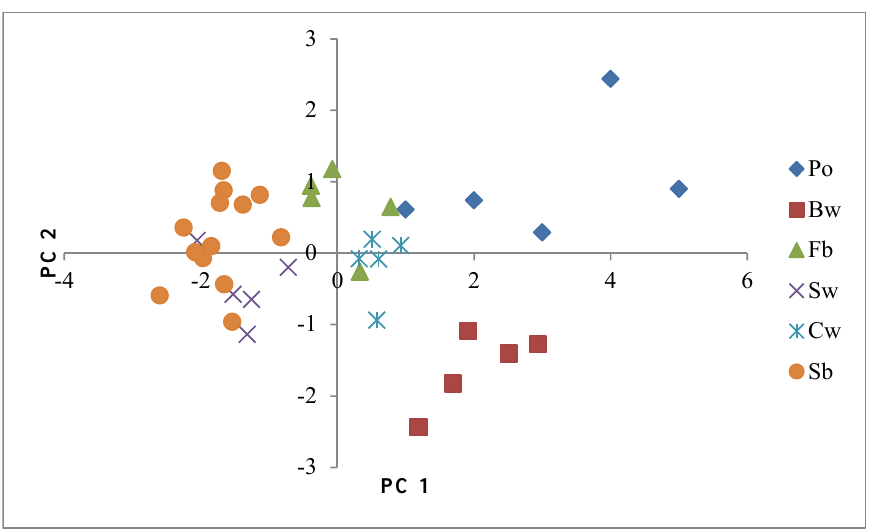
Figure 3. Principal component analysis (PCA) of foliar macronutrient concentrations across species. Po = trembling aspen; Bw = white birch; Fb = balsam fir; Sw = white spruce; Cw = white cedar; and Sb = black spruce.